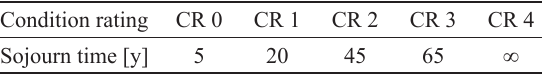
Table 4. Sojourn times of condition states for the exponential Markov process model